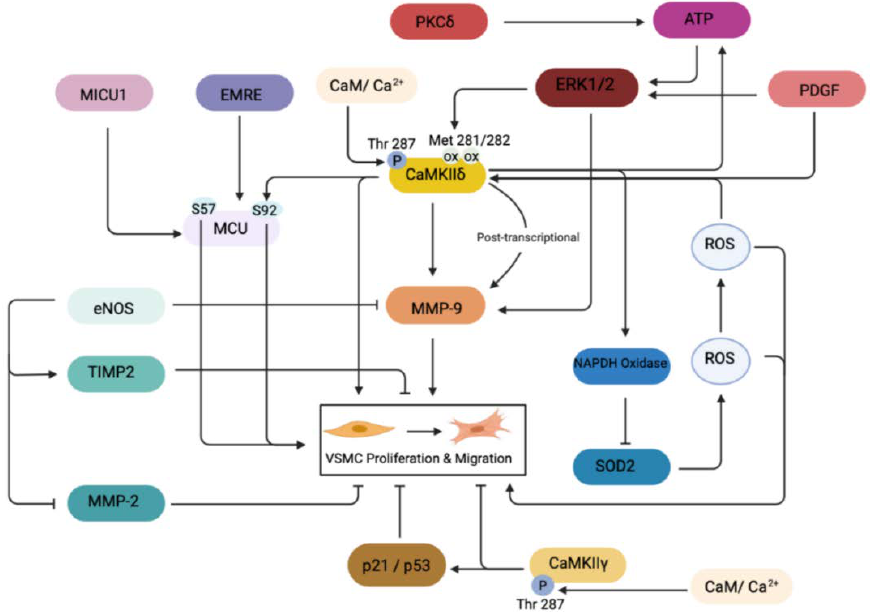
Figure 1. The regulatory mechanisms of vascular smooth muscle cell migration and proliferation. Potential up- and down-regulatory mechanisms of vascular smooth muscle cell migration (VSMC) involving both CaMKII-dependent and -independent mechanisms at both transcriptional and post- transcriptional levels. CaMKII γ expression and activation leads to promotion of VSMC proliferation and migration, both directly and indirectly, through p21 and p53 cell cycle inhibitors. CaMKII δ expression leads to increased VSMC migration and proliferation. PKC δ and PDGF both upregulate CaMKII δ to increase VSMC migration and proliferation. PKC δ works by upregulating ERK1/2 activity via ATP, leading to increased CaMKII δ activity. PDGF acts directly and indirectly via ERK1/2 to upregulate CaMKII δ , leading to VSMC migration and proliferation. MCU expression is upregulated by MICU1 and EMRE, leading to the promotion of VMSC migration and proliferation. MMP-9 is upregulated by CaMKII δ and ERK1/2, leading to increased VSMC migration and proliferation, while eNOS downregulates MMP-9. eNOS further downregulates MMP-2 and upregulates the tissue inhibitor of metalloproteinases 2 (TIMP2) to decrease VSMC migration and